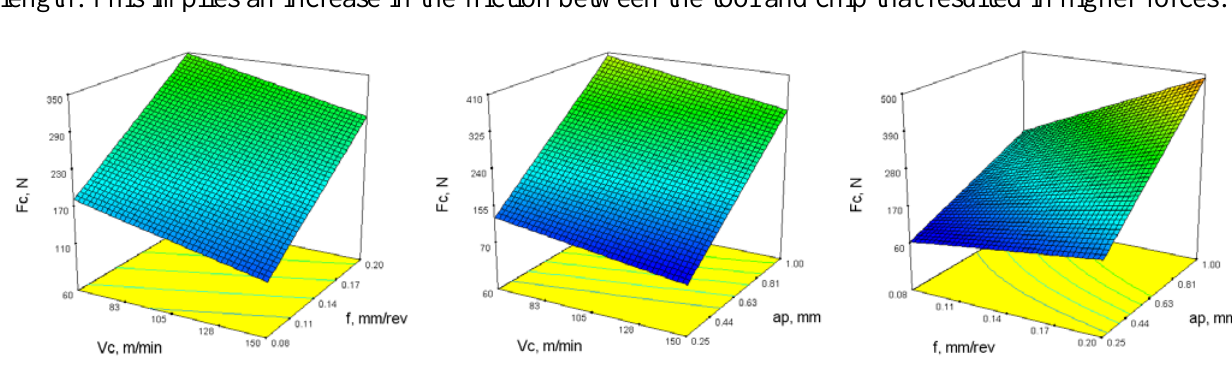
Fig. 13. Surface and contour plots for Fc